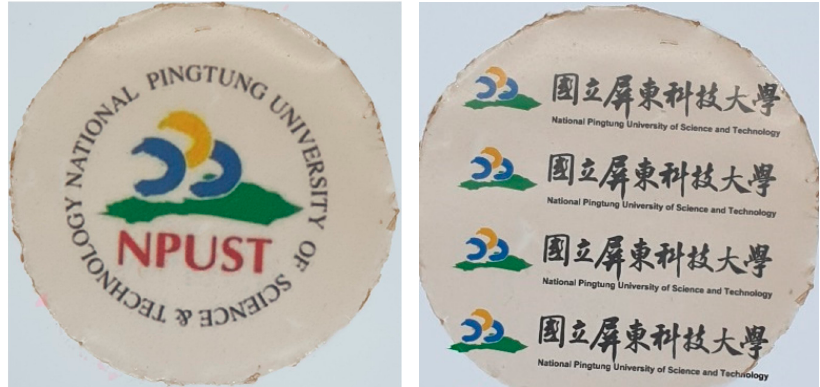
Figure 1. Visual appearance of taro peel starch film using different logos.